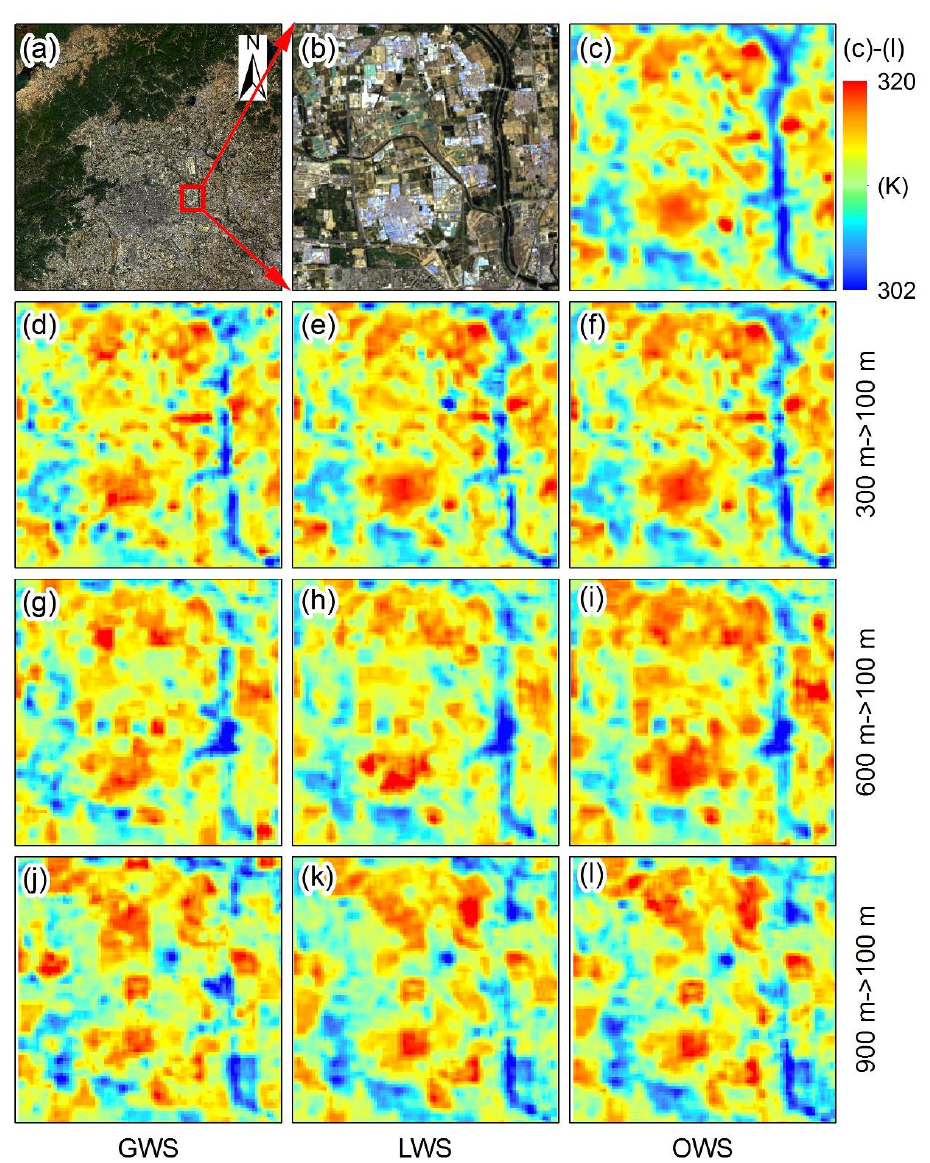
Figure 8. Results of DLST for the urban area on May 7, 2017. ( a ) RGB true-color composite of Landsat 8; ( b ) subsets of ( a ); ( c ) reference LST; ( d ) GWS (300 m → 100 m); ( e ) LWS (300 m → 100 m); ( f ) OWS: (300 m → 100 m); ( g ) GWS (600 m → 100 m); ( h ) LWS (600 m → 100 m); ( i ) OWS (600 m → 100 m); ( j ) GWS (900 m → 100 m); ( k ) LWS (900 m → 100 m); ( l ) OWS (900 m → 100 m).